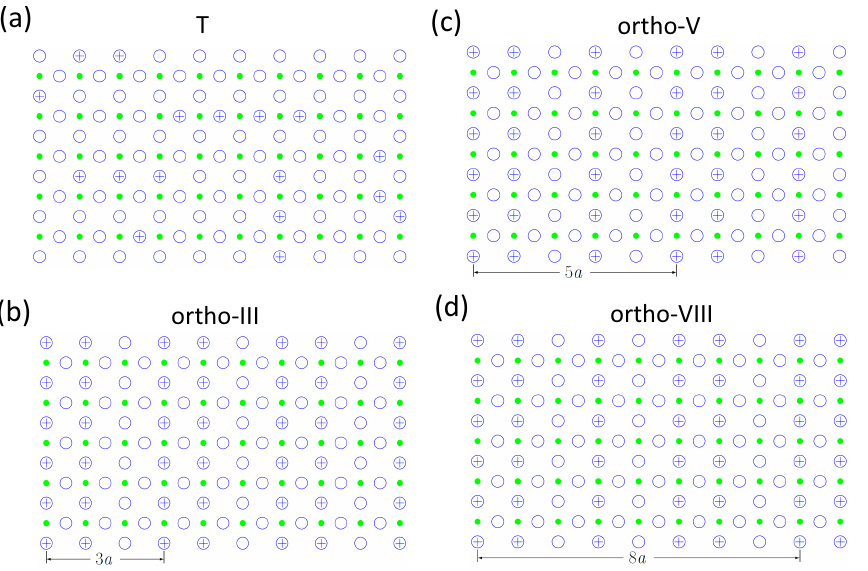
Figure 4. Idealized sketches of the phases ( a ) T, describing the tetragonal phase for δ > 0.7, ( b ) ortho- III ( δ = 0.33) with a periodicity of 3 a , ( c ) ortho-V ( δ = 0.4) with a periodicity of 5 a and ( d ) ortho-VIII ( δ = 0.375) with a periodicity of 8 a . Redrawn from Ref.